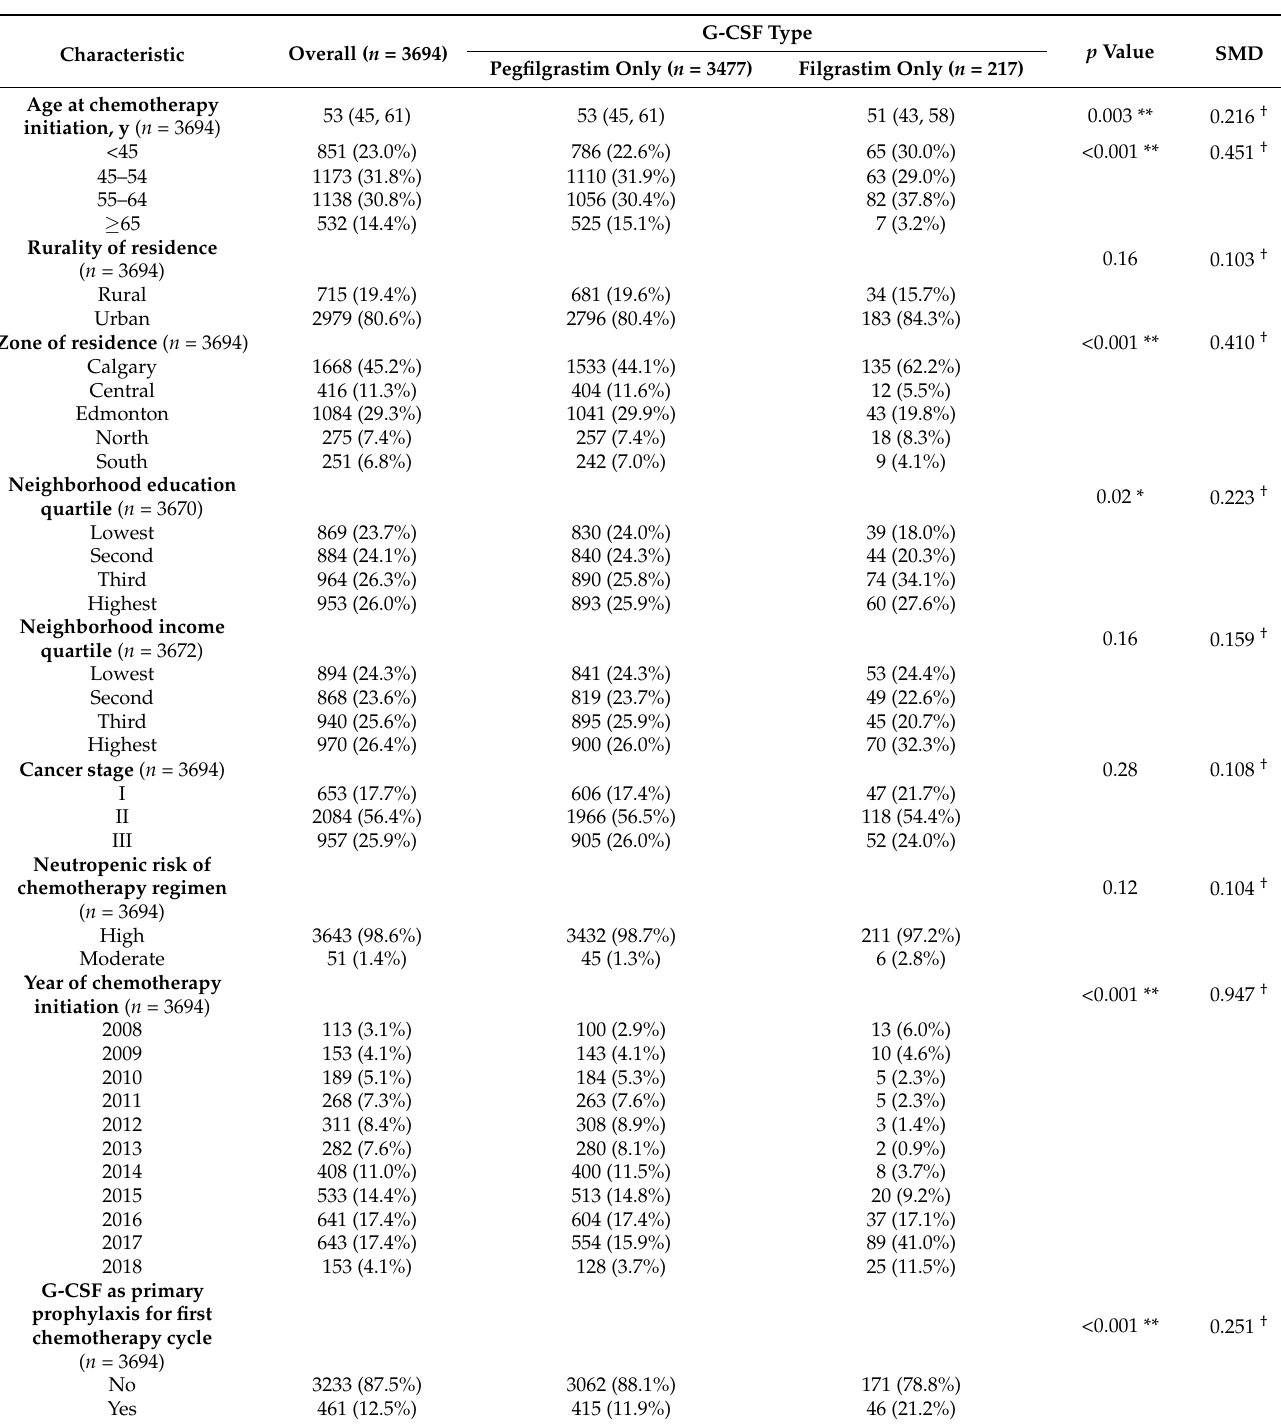
Table 2. Baseline characteristics among patients who received either filgrastim or pegfilgrastim, stratified by G-CSF